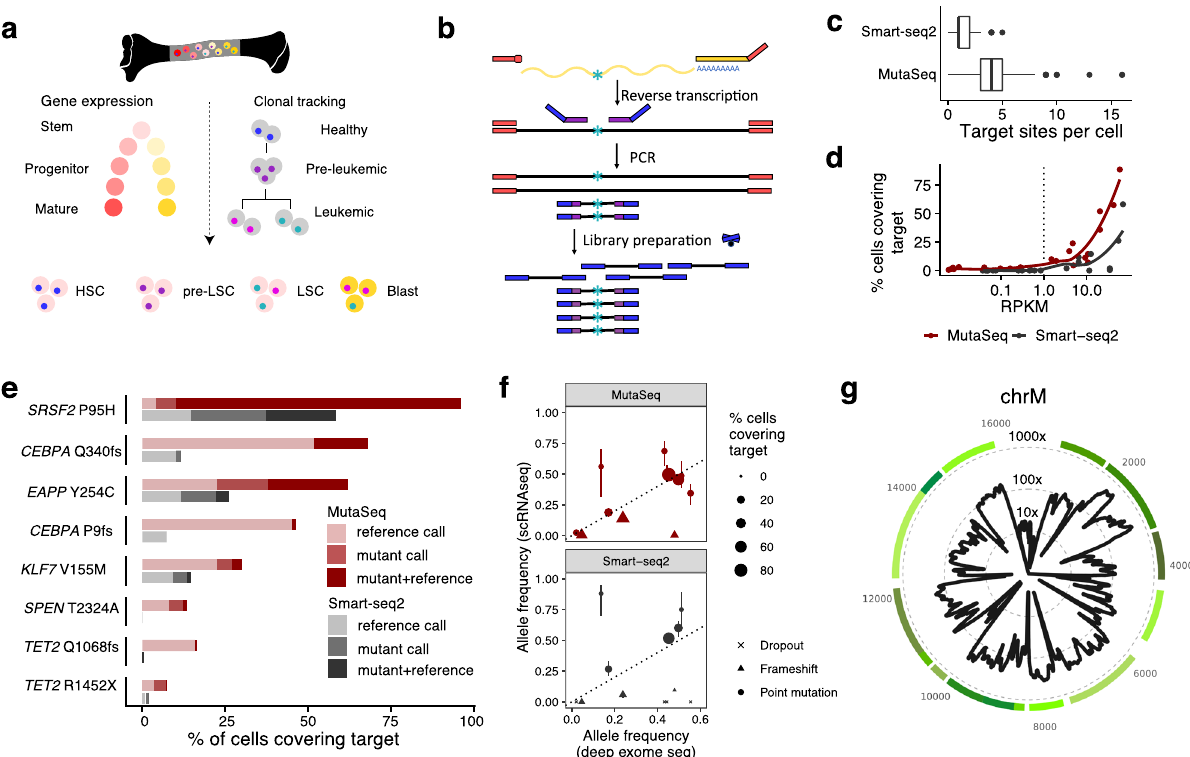
Fig. 1 MutaSeq for high-quality single-cell RNA-seq data with clonal information. See also Supplementary Fig. 1. a Overview of the study. HSC: hematopoietic stem cell, (pre-)LSC: (pre-)leukemic stem cell, Blast: mature leukemic blast. b Overview of the MutaSeq method. Targeting primers (purple) are included during the cDNA ampli fi cation step of the Smart-seq2 protocol. Targeting primers are directly fused to illumina library adapters (blue) and therefore get ampli fi ed ef fi ciently during library preparation. Tagmentation introduces the same adapters to the full-length cDNA product. c Number of target sites covered per cell, across n = 206 (Smart-seq2) or n = 658 CD34 + (MutaSeq) bone marrow cells from patient P1 (see the Methods section Data visualization, for a de fi nition of boxplot elements). d Mean gene expression of genes containing mutations of interest is plotted against the fraction of cells in which the mutation is covered. e Fractions of cells covering key non-synonymous mutations observed in the patient. Reference call: The reference allele was observed. Mutant call: the mutant allele, as de fi ned by bulk exome sequencing (Supplementary Data 1) was observed. Mutant + Reference: both alleles were observed. f Allele frequency estimates derived from deep exome sequencing compared to allele frequency estimates derived from MutaSeq (red dots, n = 2208 single cells) or Smart-seq2 (gray dots, n = 206 single cells). Dot size indicates coverage at target site. Point shape indicates the type of mutation. Error bars indicates interquartile range. See fi gure source data for complete speci fi cation of sample size used to derive statistics ( n ). g Coverage of the mitochondrial genome in MutaSeq data. See Supplementary Fig. 1j for a comparison across methods. Green line segments correspond to genes in the mitochondrial